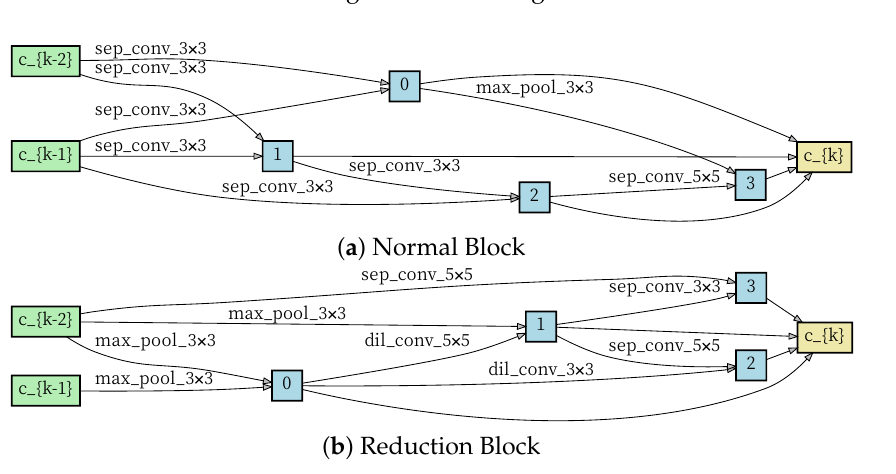
Figure 6. The normal and reduction block learned by SACN in third stage.